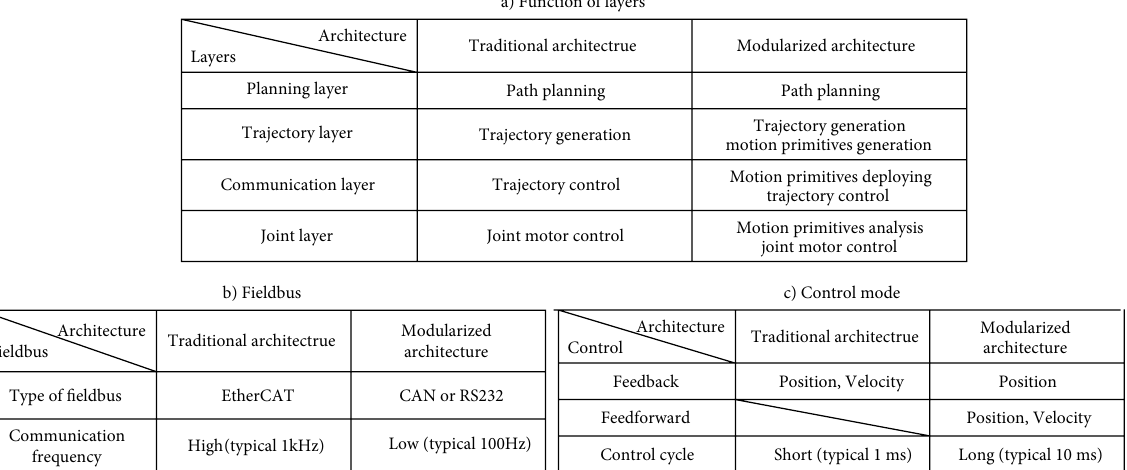
a) Function of layers